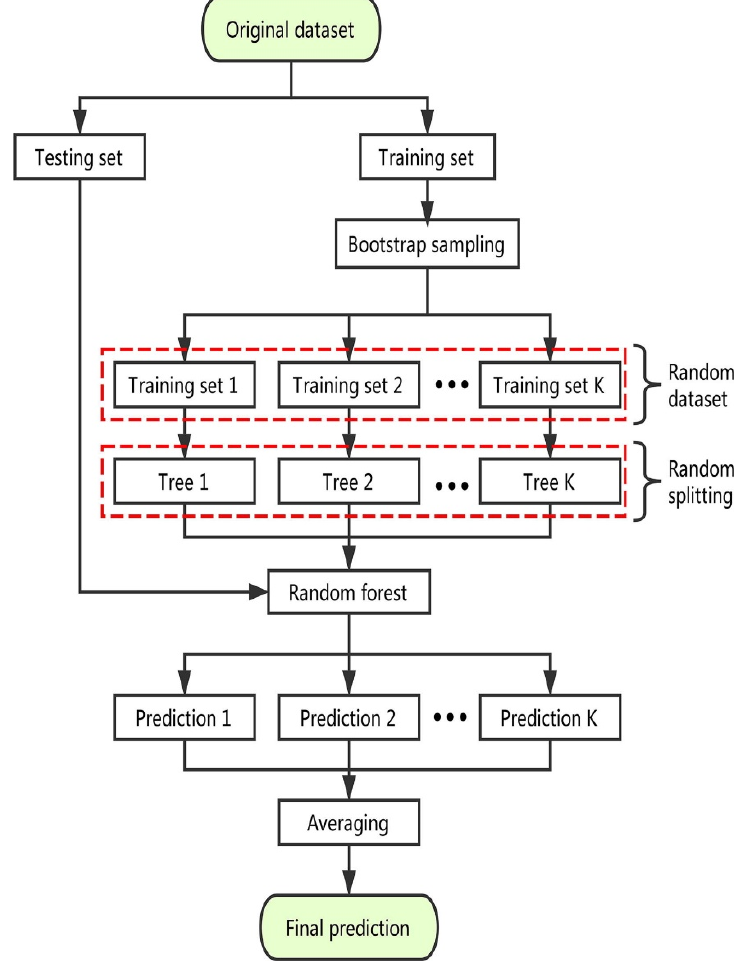
Figure 6. Schematic representation of random forest algorithm [54]. Reprinted with permission from ref. [54]. Copyright 2019 Elsevier Ltd.